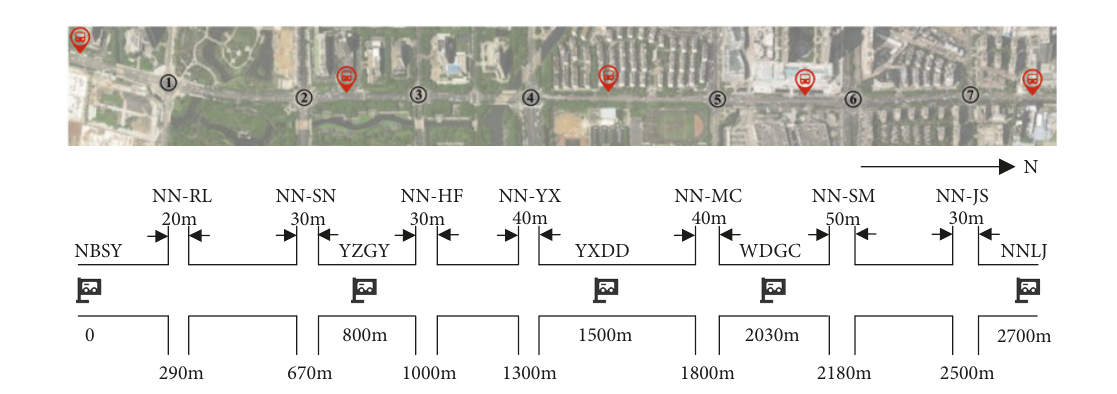
Figure 8: Layout of the Ningbo tramline.